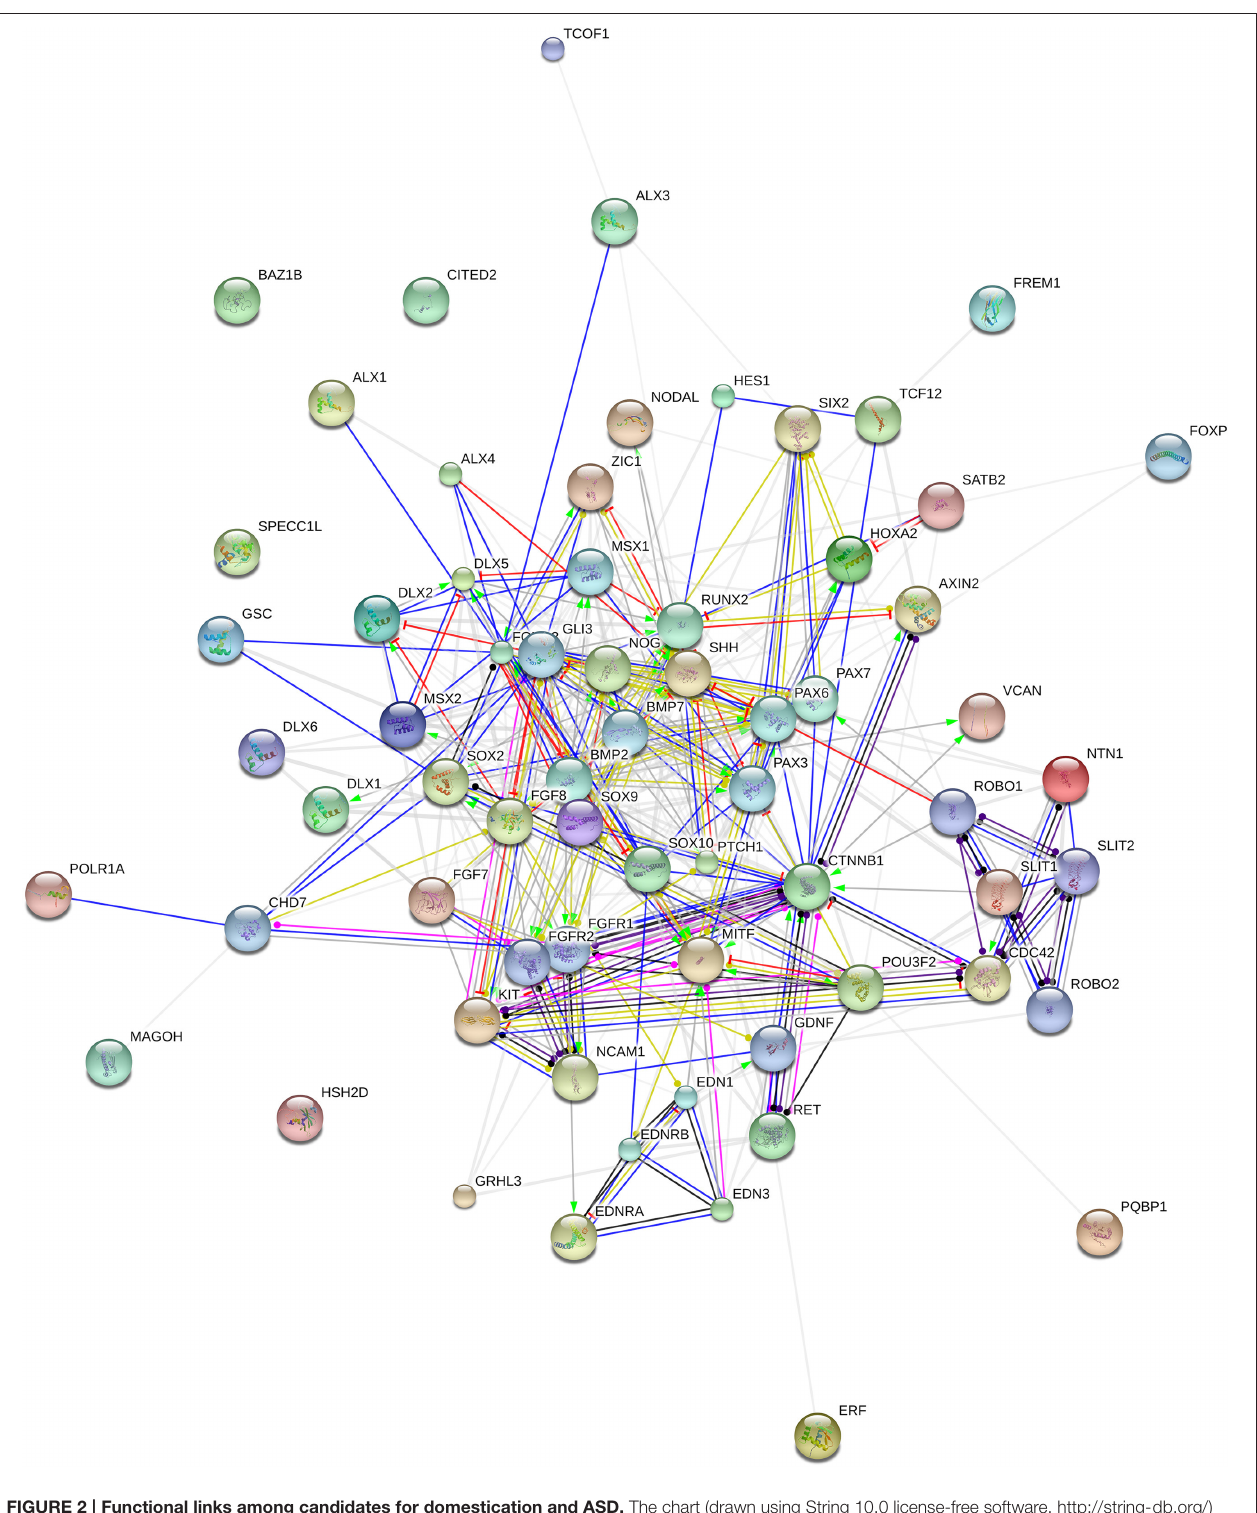
FIGURE 2 | Functional links among candidates for domestication and ASD. The chart (drawn using String 10.0 license-free software, http://string-db.org/) shows the network of known and predicted interactions among all genes listed in Table 1 . The colored nodes symbolize proteins: small nodes are proteins with unknown 3D structure, while large nodes are those with known 3D structures. The color of the edges represent different kind of known protein-protein associations. Green: activation, red: inhibition, dark blue: binding, light blue: phenotype, dark purple: catalysis, light purple: posttranslational modification, black: reaction, yellow: